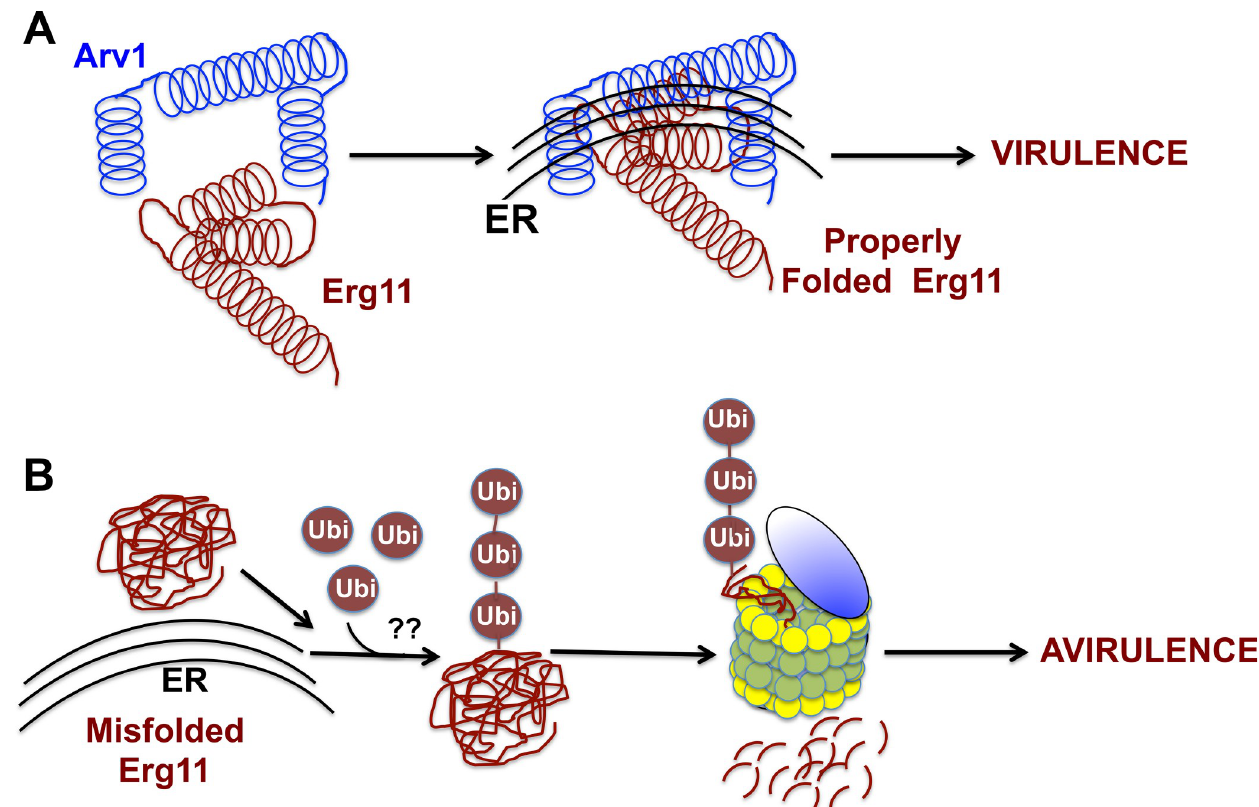
Fig 14. Model depicting the role of Arv1 in maintaining Erg11 stability and virulence. (A) A direct physical interaction between Arv1 and Erg11 results in stability of Erg11. This interaction may be required for maintaining Erg11 tertiary structure and/or tether it to the ER membrane. A stable Erg11-Arv1 complex confers virulence. (B) Erg11 becomes misfolded in the absence of Arv1, and may be targeted to the proteosome via ubiquitination. Cells lacking a stable Erg11-Arv1 complex are azole hypersusceptible and lack virulence.